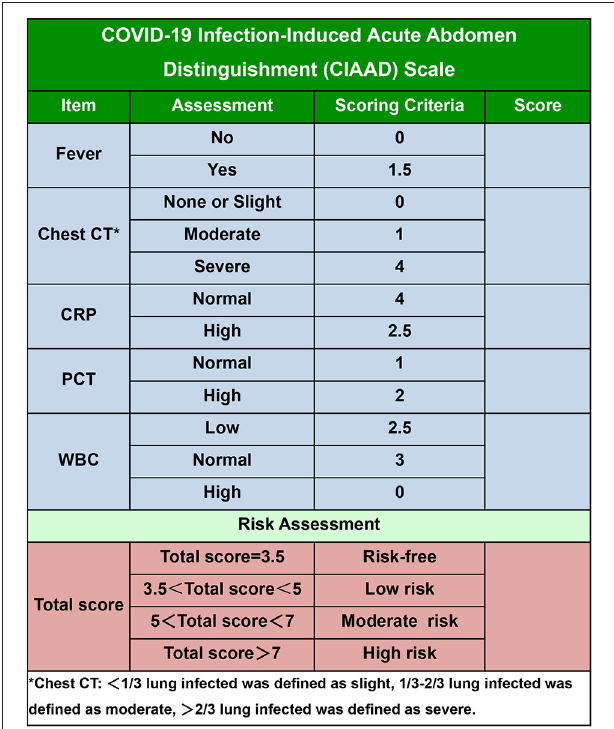
FIGURE 5 | The COVID-19 Infectious Acute Abdomen Distinguishment Scale based on the CIAAD nomogram. Patients with a total score of < 5 were considered of low risk of true SARS-CoV-2 infection, five to seven were of moderate risk, and more than seven meant high risk.